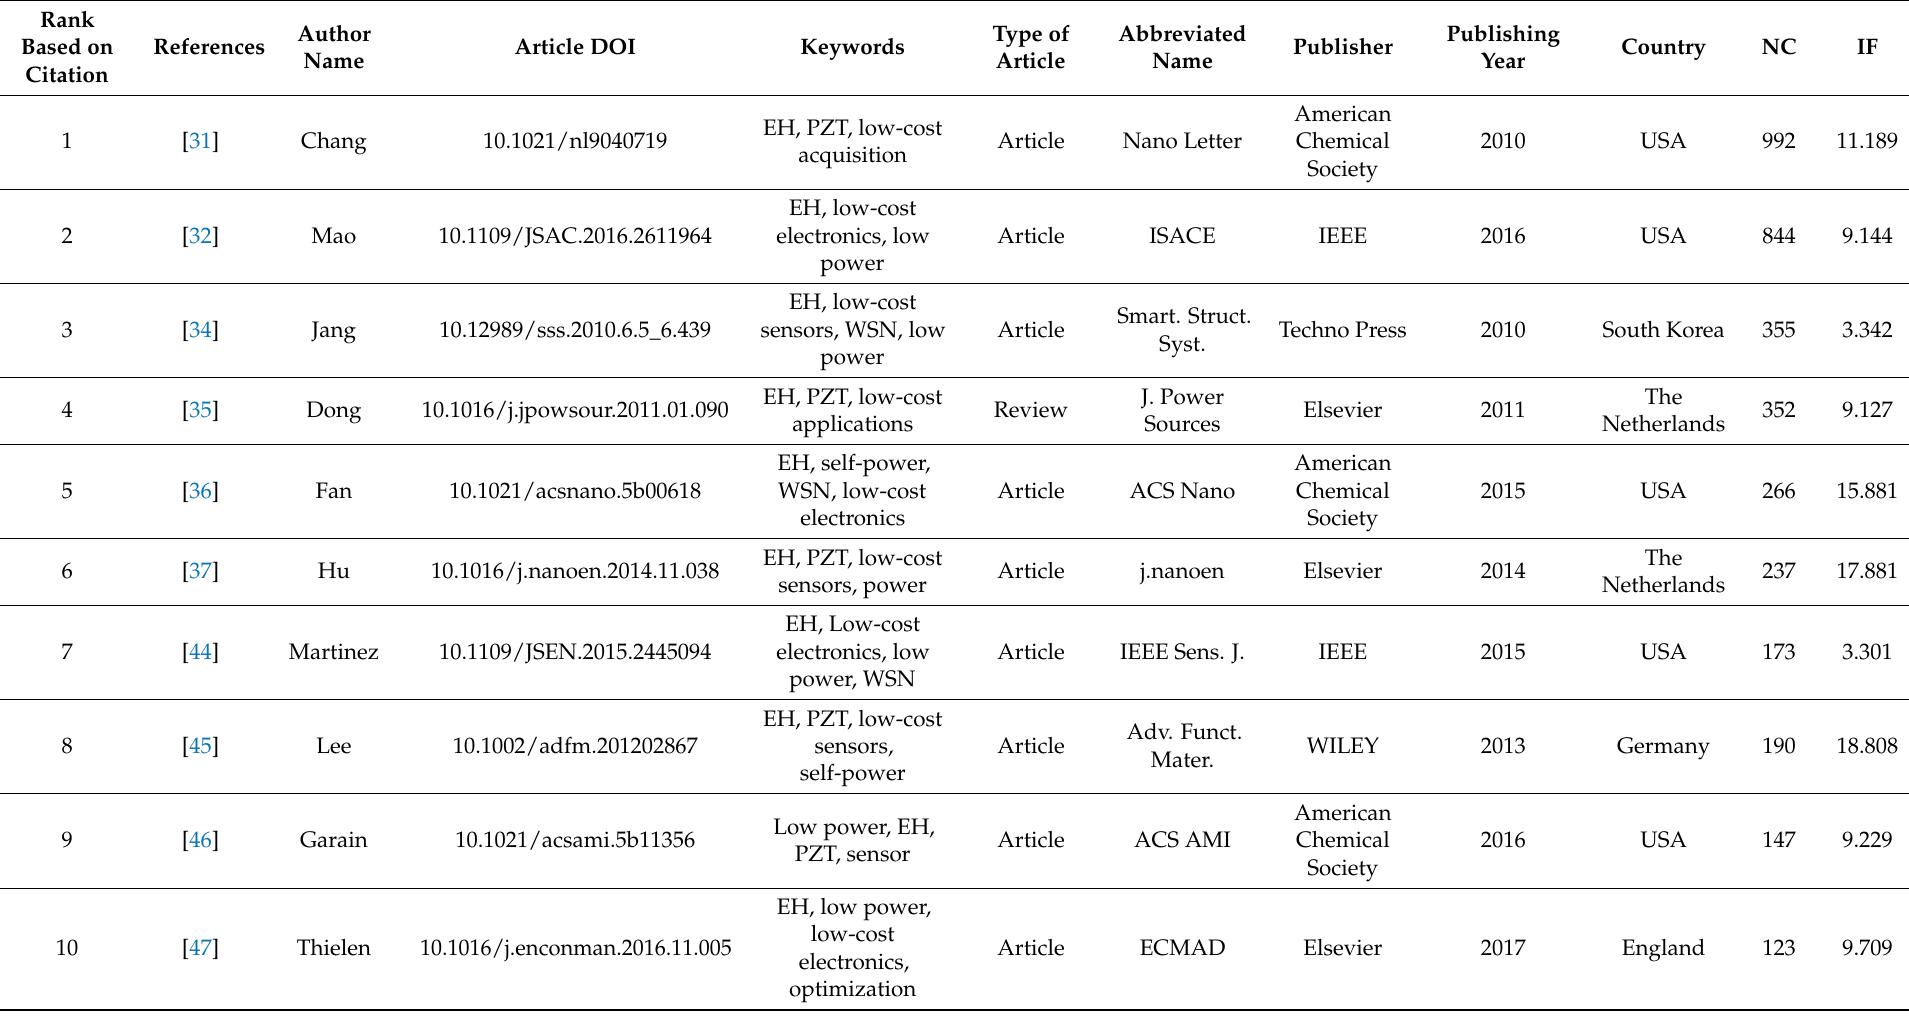
Table 3. The list of 100 highly influential papers for energy harvesting keywords and publication